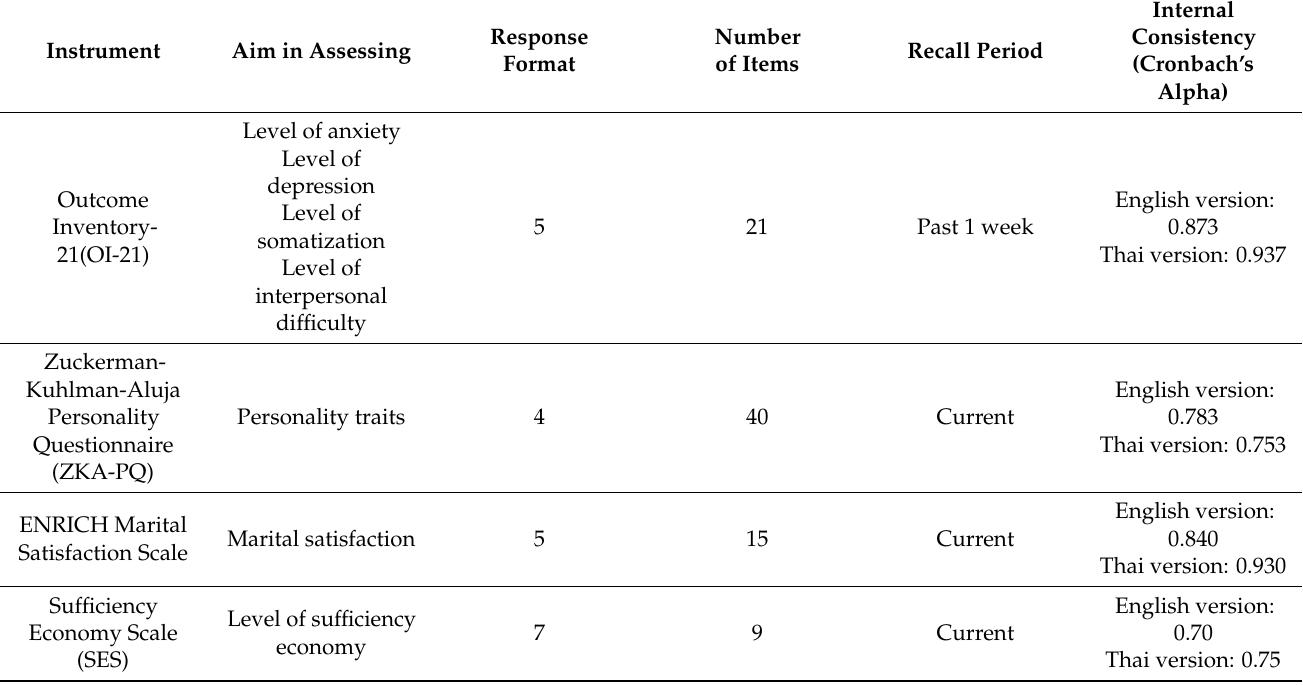
Table 2. Measurement tools of the